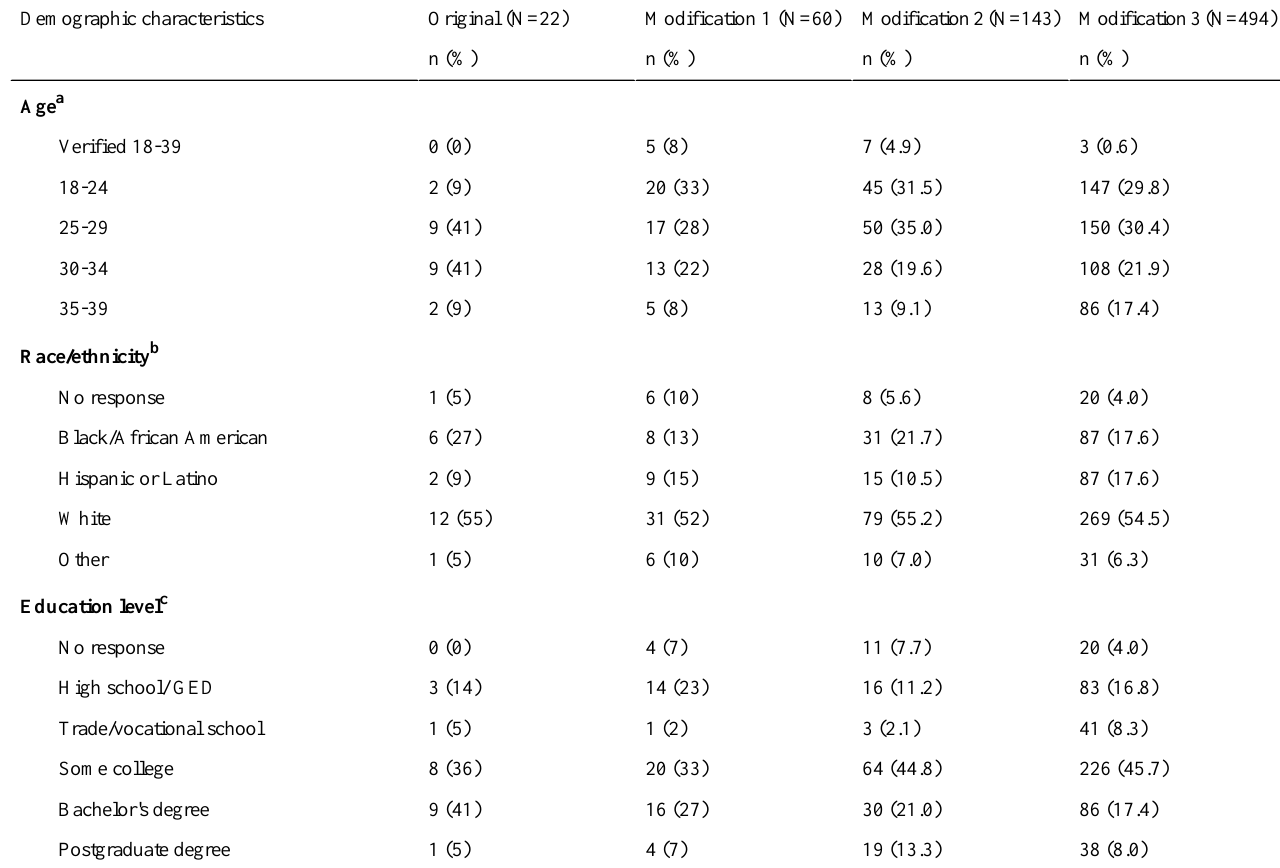
Table 3. Demographic distribution of participants during the enrollment